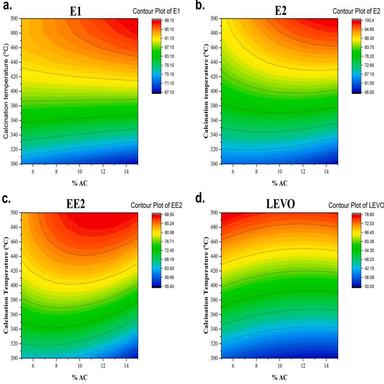
Response Surface Methodology (RSM) for hormones removal by TiO2-AC composites synthetized according to DoE using two variables: AC mass proportion in TiO2-AC composites (AC%) vs temperature of calcination in ◦C (Temp). a. E1 removal (%); b. E2 removal (%); c. EE2 removal (%); and d. LEVO removal (%).